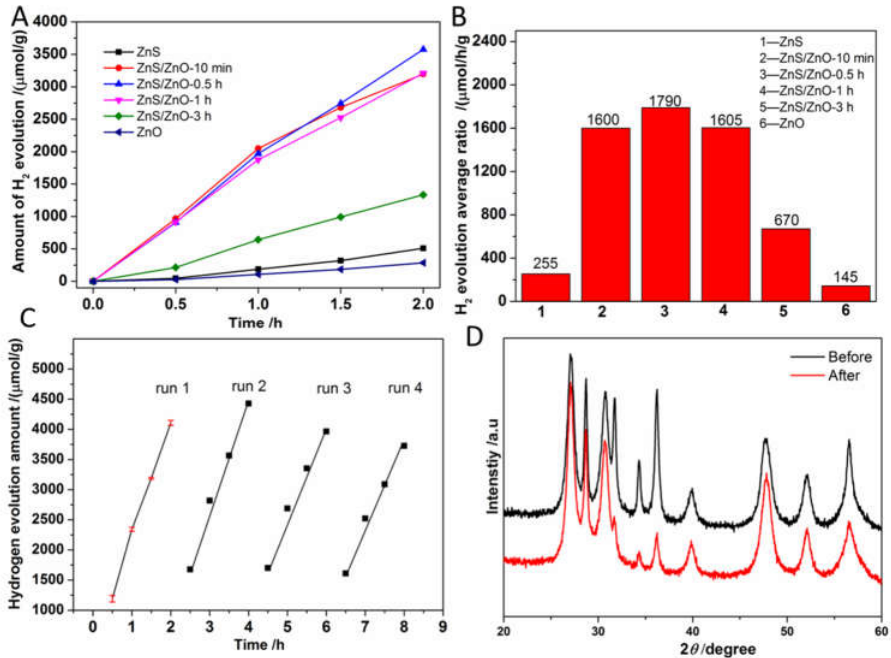
Figure 8. ( A ) and ( B ) Time course of H 2 evolution activity and the corresponding average rates of H 2 evolution over the as-prepared samples, ( C ) recycle tests for photocatalytic reaction over ZnS/ZnO-0.5 h, ( D ) the XRD diffraction patterns before and after photocatalytic reaction. Table 1. Comparison of the photocatalytic H 2 evolution activities of ZnS/ZnO.